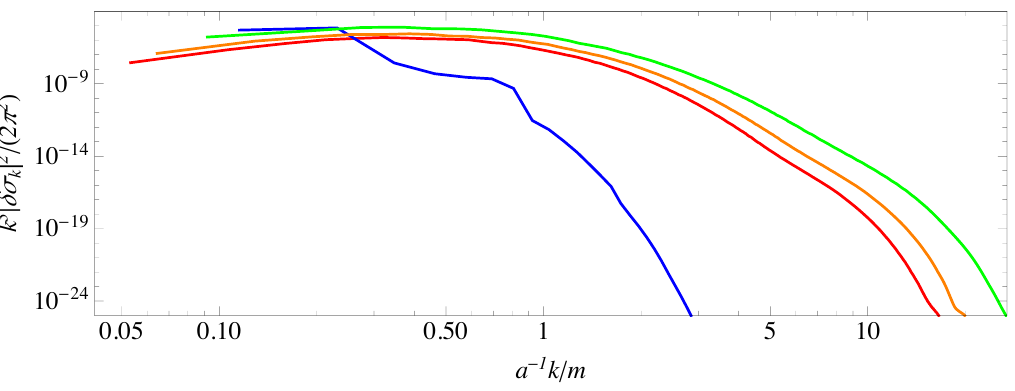
Figure 12 . Spectrum of (cid:13)uctuations at di(cid:11)erent moments in time: at the end of linear preheating at a ’ 1 : 16 (blue), shortly after the beginning of the non-linear regime at a ’ 1 : 45 (green), at a ’ 2 : 1 (orange), and at the end of the simulation a ’ 2 : 5